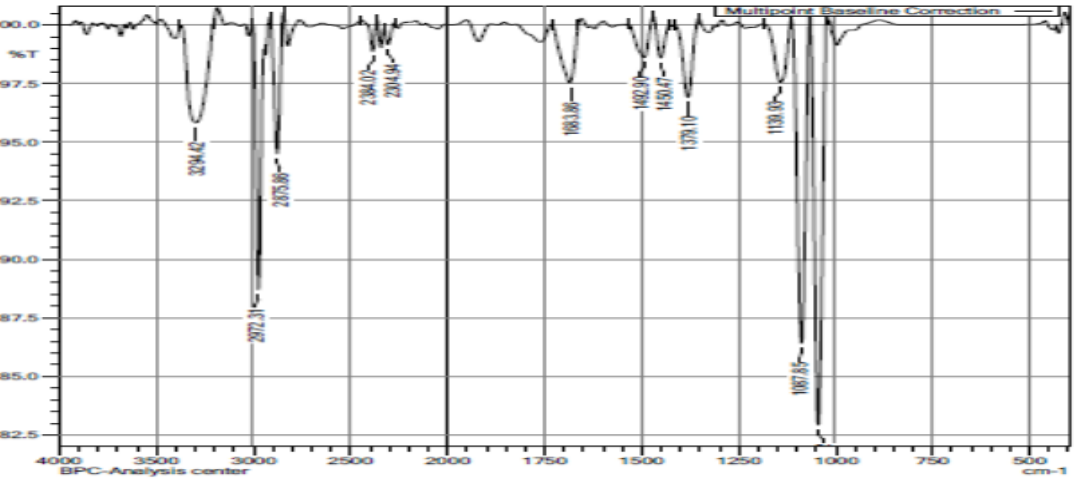
Figure 13.IR spectrum of isolated cpdC1 Table 5. interpretation of the IR bands for C1are shown below.